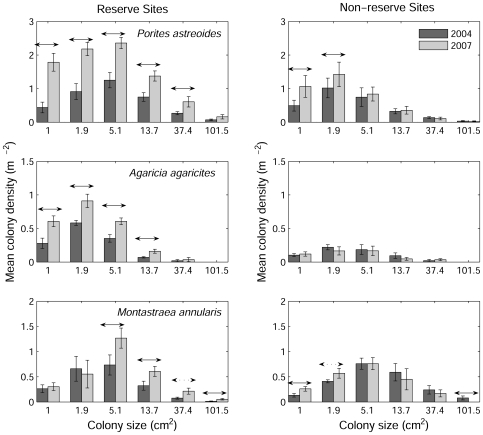
Size distributions of coral density in three coral species.Size distributions highlight changes over time (2004 to 2007) and differences between reserve and non-reserve sites. Error bars denote s.e.m. from site-averaged data. Horizontal arrows denote significant differences (one-tailed t-test, solid arrows for P<0.05, dashed arrows for 0.05<P<0.1).